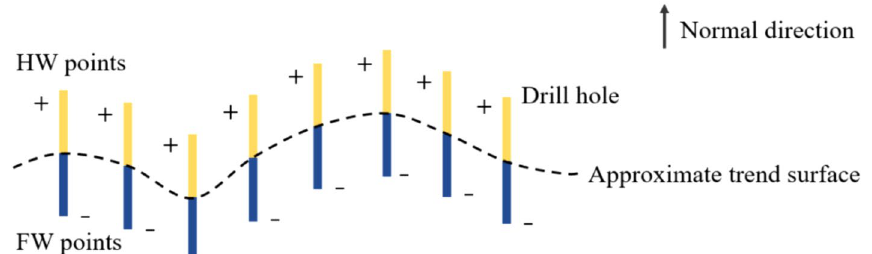
Figure 2. Construct interpolation constraints based on the drillhole